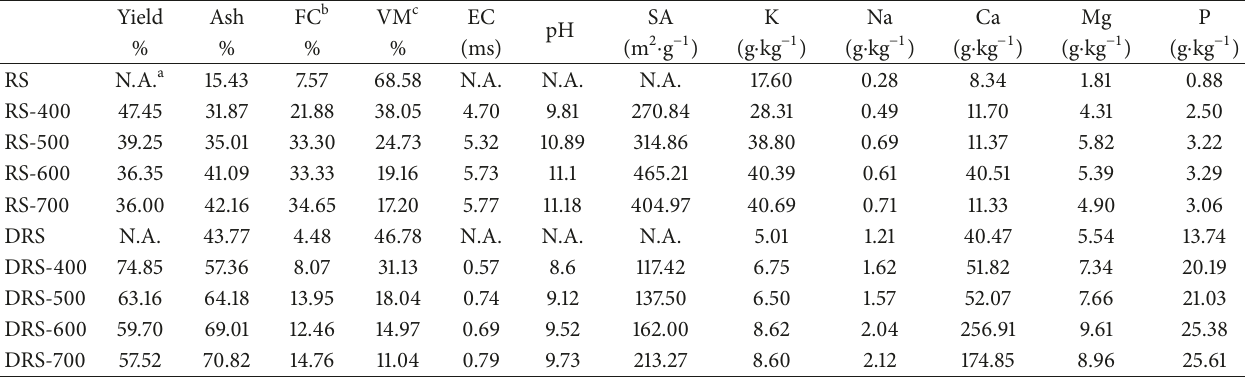
Table 1: Physicochemical properties of biochars produced at different